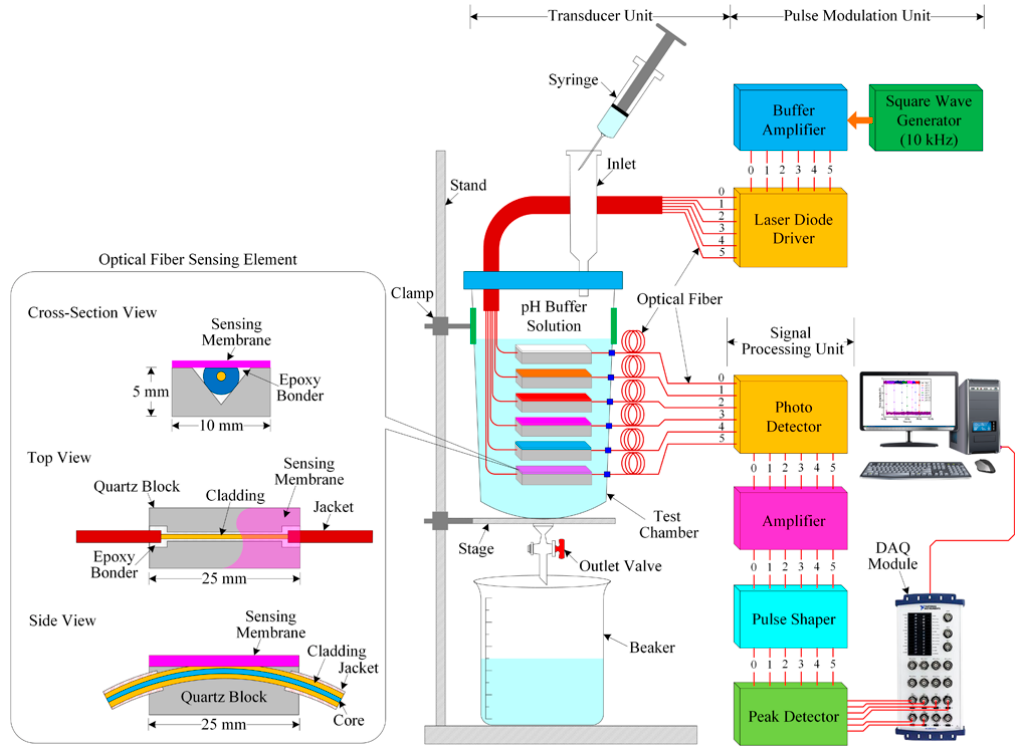
Figure 4. Schematic diagram of the experimental setup of the proposed optical-fiber PWM pH sensing system.